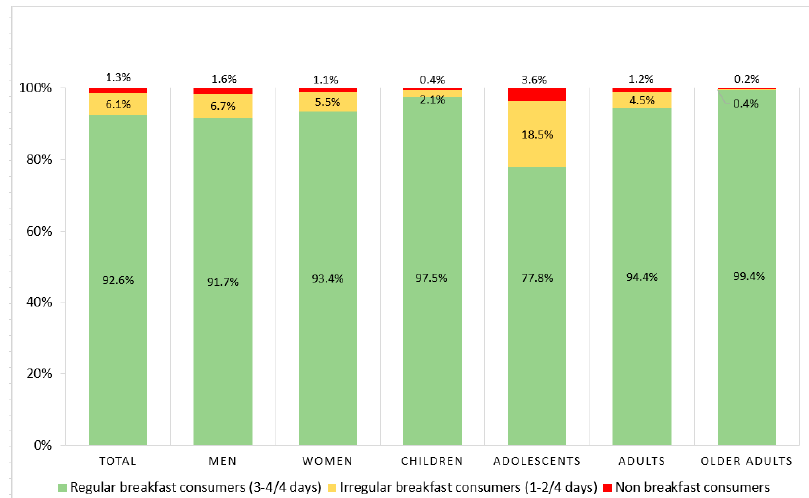
Figure 1. Regularity of breakfast consumption in the total population and stratified by gender and age.